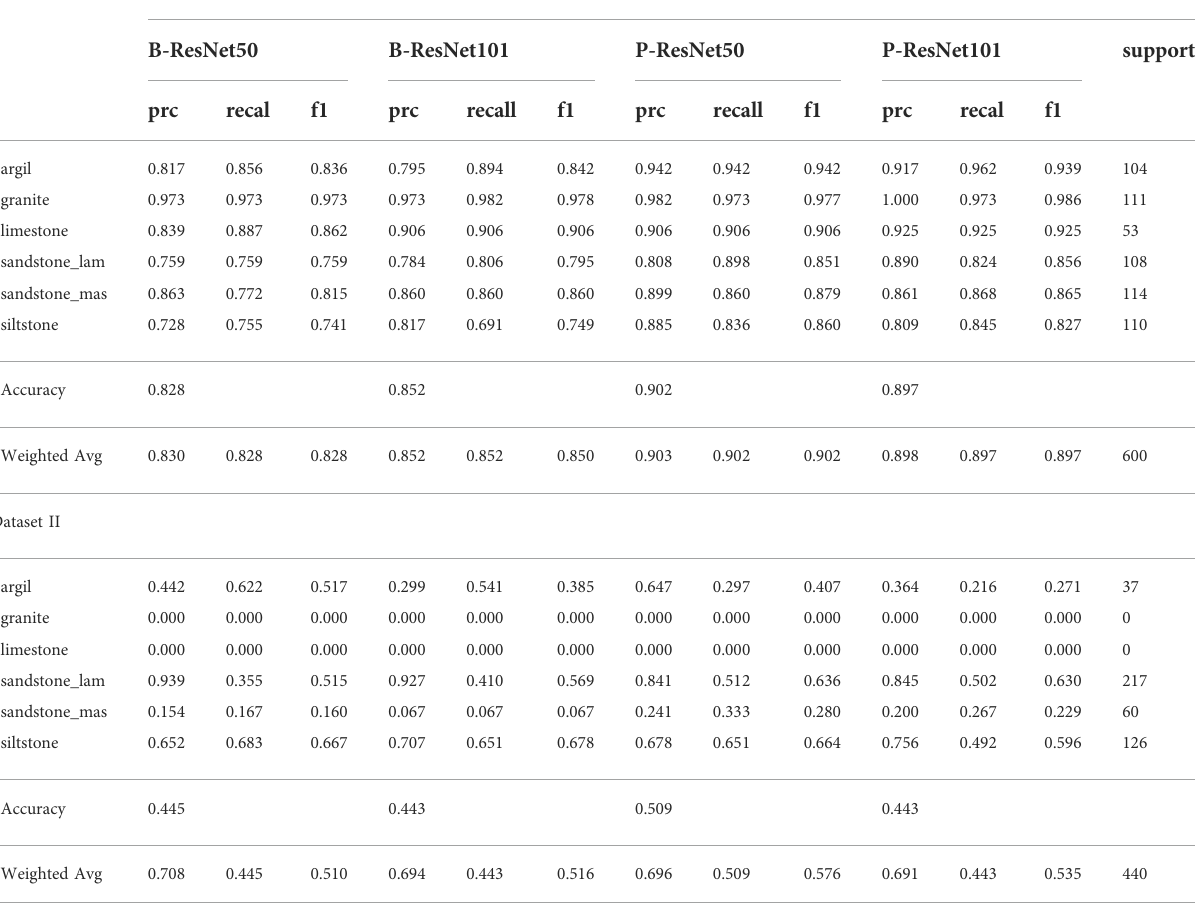
TABLE 4 Classi fi cation reports for CNN-based models for Dataset I and Dataset